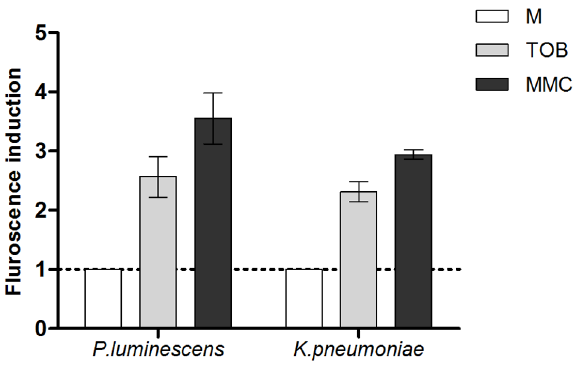
Figure 4. Sub-MIC aminoglycosides induce SOS in other pathogens. Histogram bars show the ratio of GFP fluorescence in the presence of antibiotic over fluorescence in LB and thus reflect the induction of SOS by the antibiotic. Tobramycin (TOB) concentrations were 0.01 m g/ml for Klebsiella pneumoniae and 0.0025 m g/ml for Photorhabdus luminescens . Mitomycin C (MMC) was used at 0.1 m